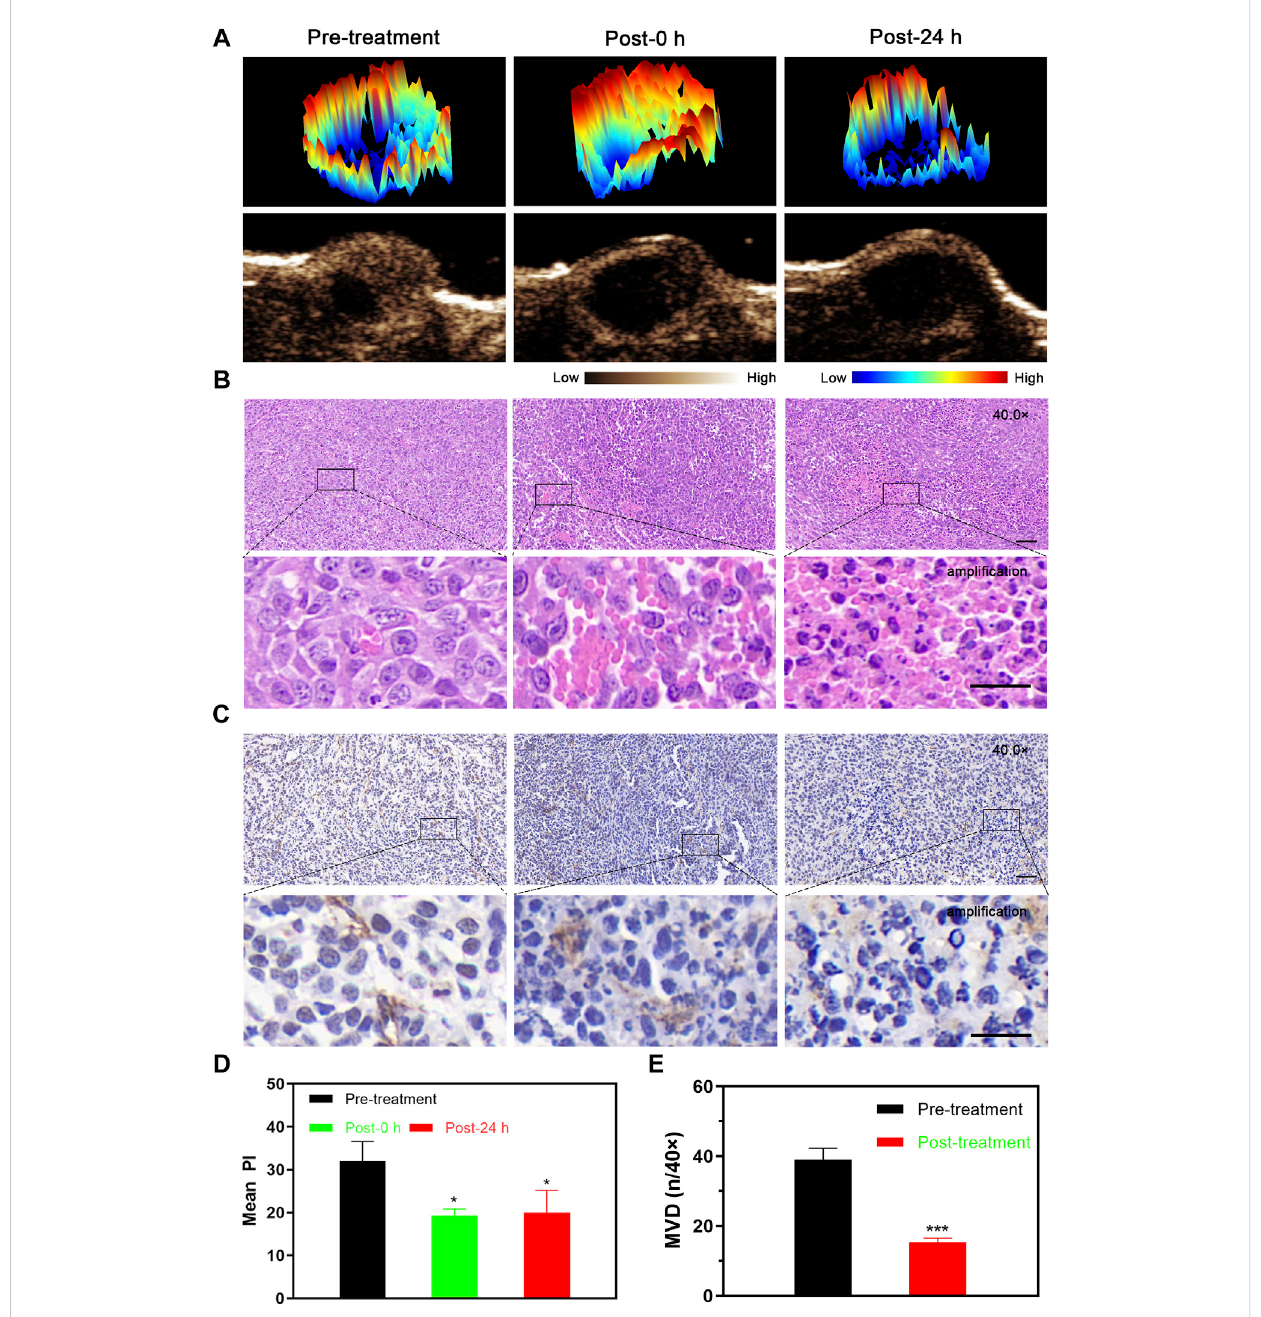
Tumor perfusion and histological changes of microvessels at different time points after LIFU-TMD therapy. (A) Representative contrast-enhanced ultrasound (CEUS)and three-dimensionalpseudo-color imagesofthe4T1tumor.H&E (B) andimmunohistochemical stainingfor theendothelial marker CD31 with brown color (C) in the 4T1 tumor by light microscopy at before treatment (Pre-treatment), immediately after treatment (Post-0 h) and 24 h later(Post-24 h);scalebar:50 μ mfor40.0ximages,20 μ mforampli fi cation. (D) Meanpeakintensity(PI)oftumorsat3-timepoints. (E) Quantitative analysis of the microvessel density (MVD) at different times. Data are presented as mean ± SD ( n = 3), * p < 0.05, ** p < 0.01, *** p <